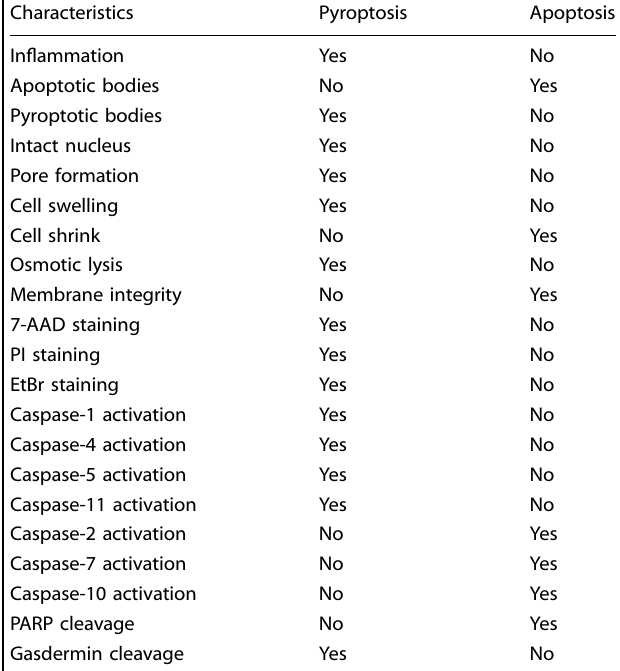
Table 2. Differences between pyroptosis and apoptosis